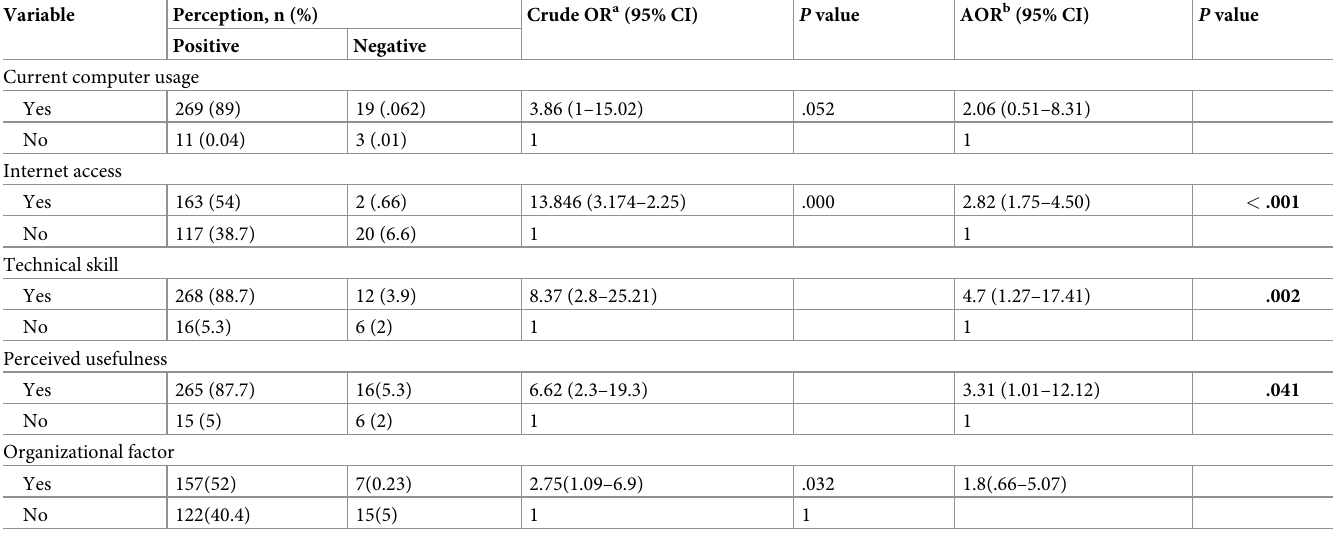
Table 5. Bivariable and multivariable logistic regression analysis of factors with perception among physicians at public health hospitals in Amhara region North- west Ethiopia 2021(N = 302). Variable Perception, n